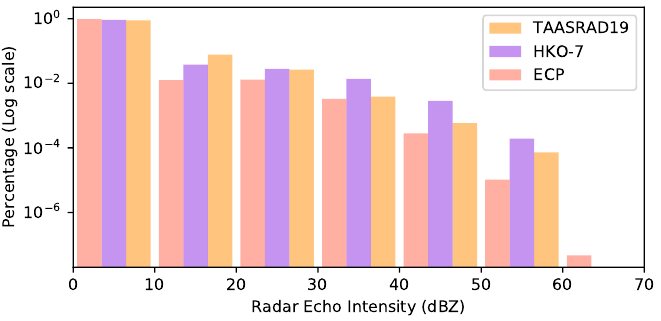
Figure 1. Distribution of different radar echo intensity levels. ECP and TAASRAD19 were collected from the north temperate zone, and HKO-7 was collected from the